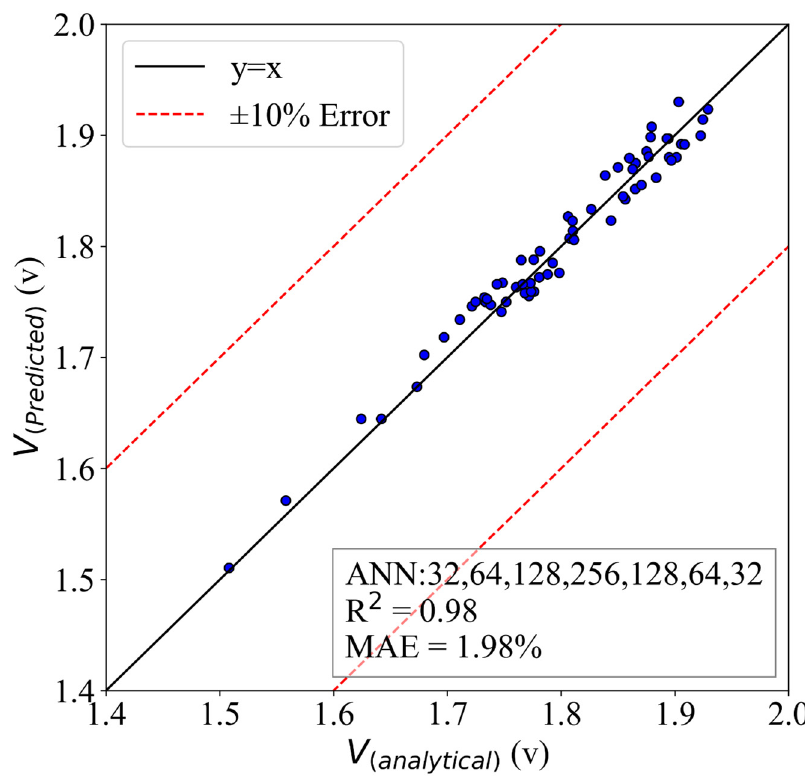
Figure 14. The ANN model of voltage with an HL structure of (32,64,128,256,128,64,32).